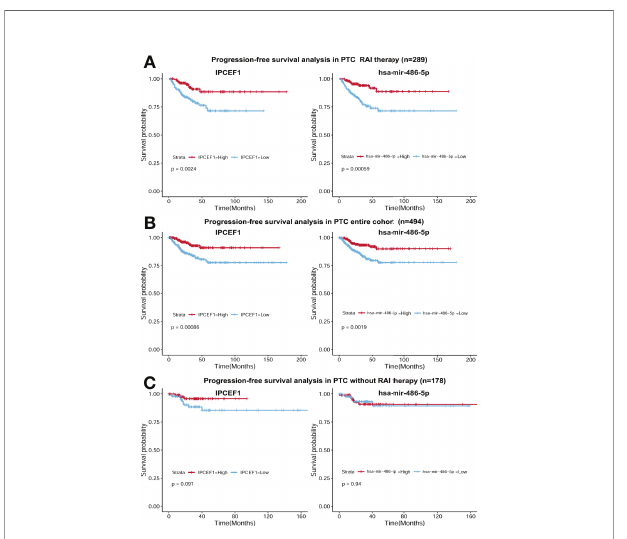
FIGURE 6 | Survival curves of PFS in the PTC RAI therapy cohort (A) , in the all-PTC group (B) and in PTC without RAI therapy (C) with high and low expressions of IPCEF1 and hsa-mir-486-5p.